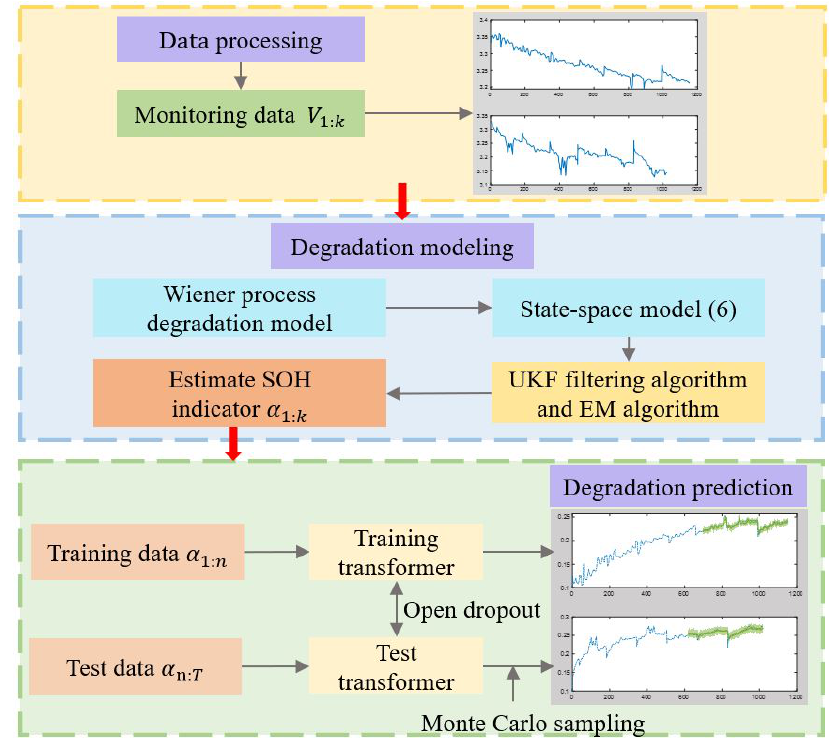
Figure 3. The hybrid method for degradation of